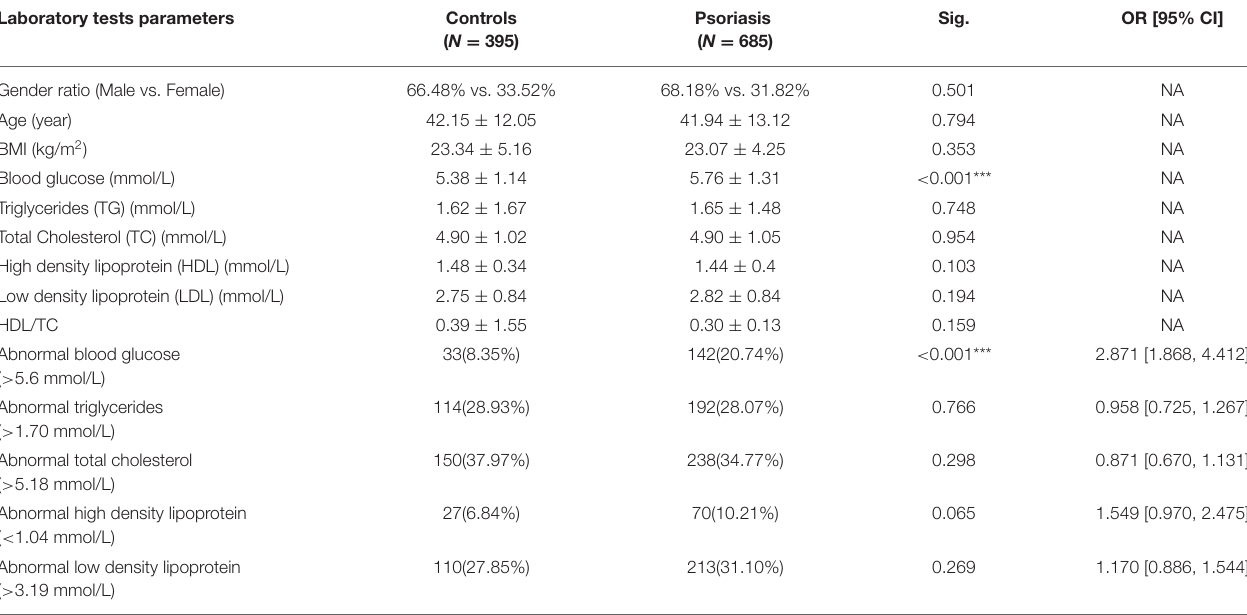
TABLE 1 | Fasting blood glucose and lipids levels in patients with psoriasis and control groups. Laboratory tests